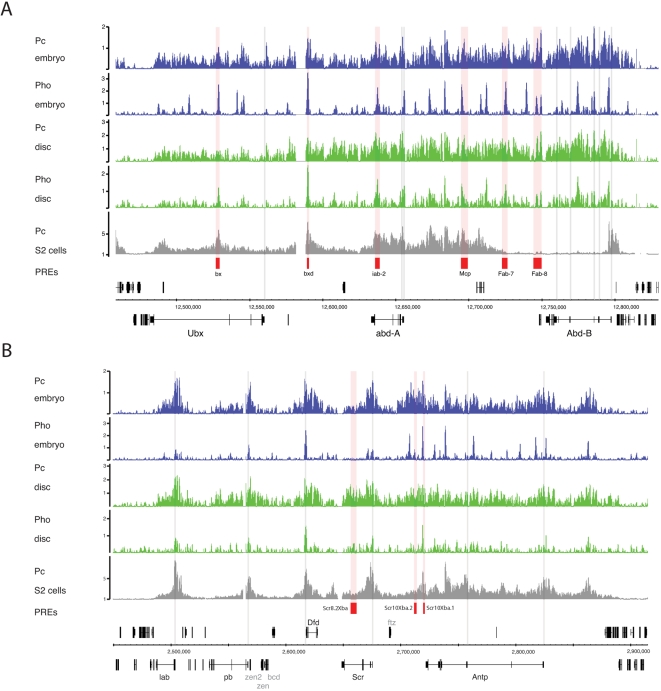
Pc and Pho binding profiles at the Hox complexes.Enrichment profiles across the BX-C (A) and the ANT-C (B) showing broad Pc binding and more discrete Pho peaks. Characterised PREs are shown in red and Hox gene promoters as grey verticals. (A) In the BX-C characterised PREs are generally marked by Pho peaks and maximae in the Pc profile but there are many more Pho peaks than characterised PREs. Significant Pc and Pho binding is associated with the three BX-C Hox genes in both the embryo and in the T3 discs despite the active expression of Ubx in the T3 discs. (B) In the ANT-C there is a strong correspondence between Pho peaks/Pc maximae and the Hox gene promoters particularly in the cases of lab, pb, Dfd and Scr. The long Antp transcription unit is associated with multiple Pho peaks. One of the previously characterised PREs is associated with a major Pho peak. Significant Pc and Pho binding is associated with the ANT-C Hox genes in both the embryo and in the T3 discs even though Antp is not transcriptionally silenced in the T3 discs. Note the other homeobox genes in the region, zen, zen2, bcd and ftz are not associated with prominent Pc or Pho binding (genes shown in grey).